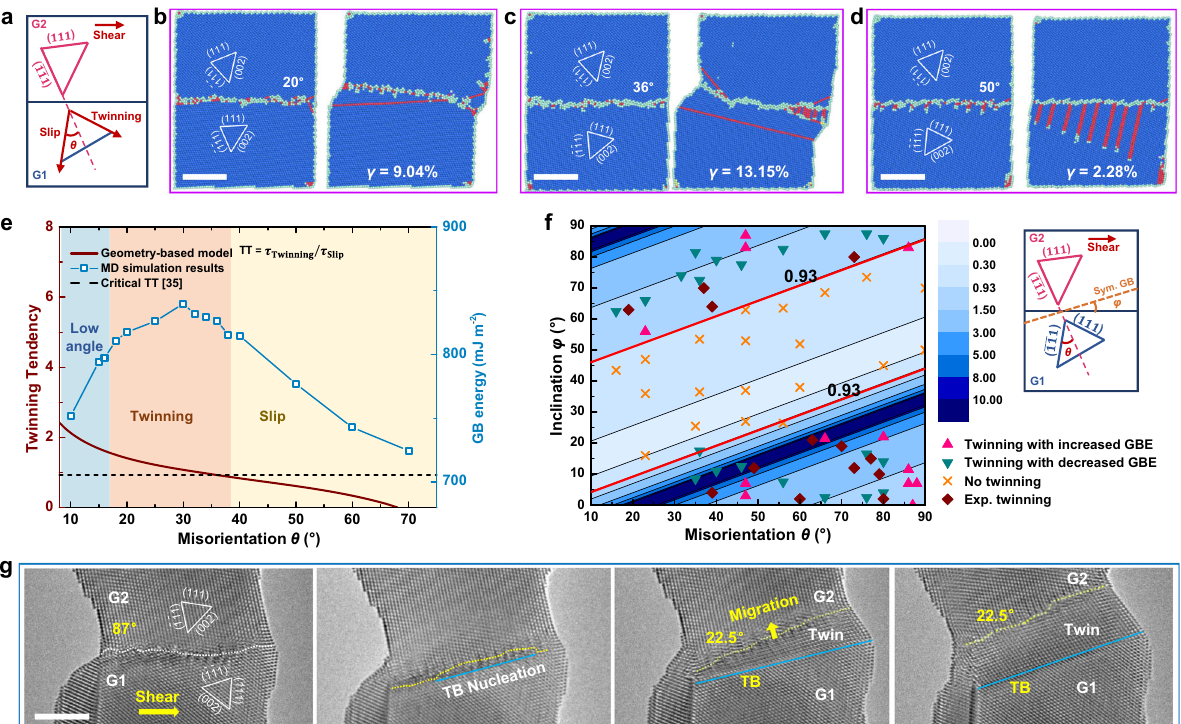
Fig. 4 Geometry-based twinning tendency model for self-adjust GB deformation. a Schematic delineating the GB misorientation θ between G1 and G2, with the twinning and slip planes of G1 labelled. b , c Dynamic GB adjustment mediated by deformation twinning of two [1 (cid:1) 10] tilt GBs with θ = 20° and 36°. d Dislocation emission and slip at the GB with θ = 50°. e Twinning tendency and GB energy plotted as a function of the GB misorientation. The transitional misorientation for the twinning-slip competition was determined as 35.7°, at which the twinning tendency reaches a critical value of 0.93 (indicated by the black dotted line), con fi rmed by a series of MD simulation results (indicated by the squared data points). f Twinning tendency map considering the collective in fl uences of GB misorientation θ and inclination φ , where φ is de fi ned as the deviation angle of the actual GB plane from that of the ideally symmetric GB (see the right schematic inset). The critical twinning tendency of 0.93 is marked out in the map, veri fi ed by the data points obtained from MD simulations and experiments. The colour bar indicates the value of twinning tendency predicted by the geometry-based model. g Deformation snapshots of energetically unfavourable twinning occurred at an 87° [1 (cid:1) 10] tilt GB, leading to the formation of a 22.5° GB T-2 and a TB (indicated by the yellow and blue lines, respectively). The newly formed GB T-2 migrated smoothly via the collective gliding of GB dislocations in subsequent shear loading. All scale bars: 5